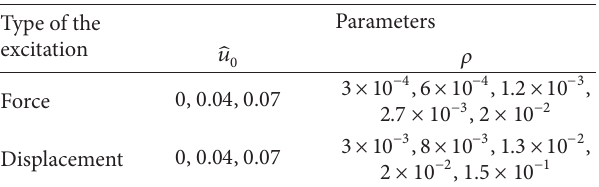
Table 2: The offset displacement and excitation amplitude for the two types of